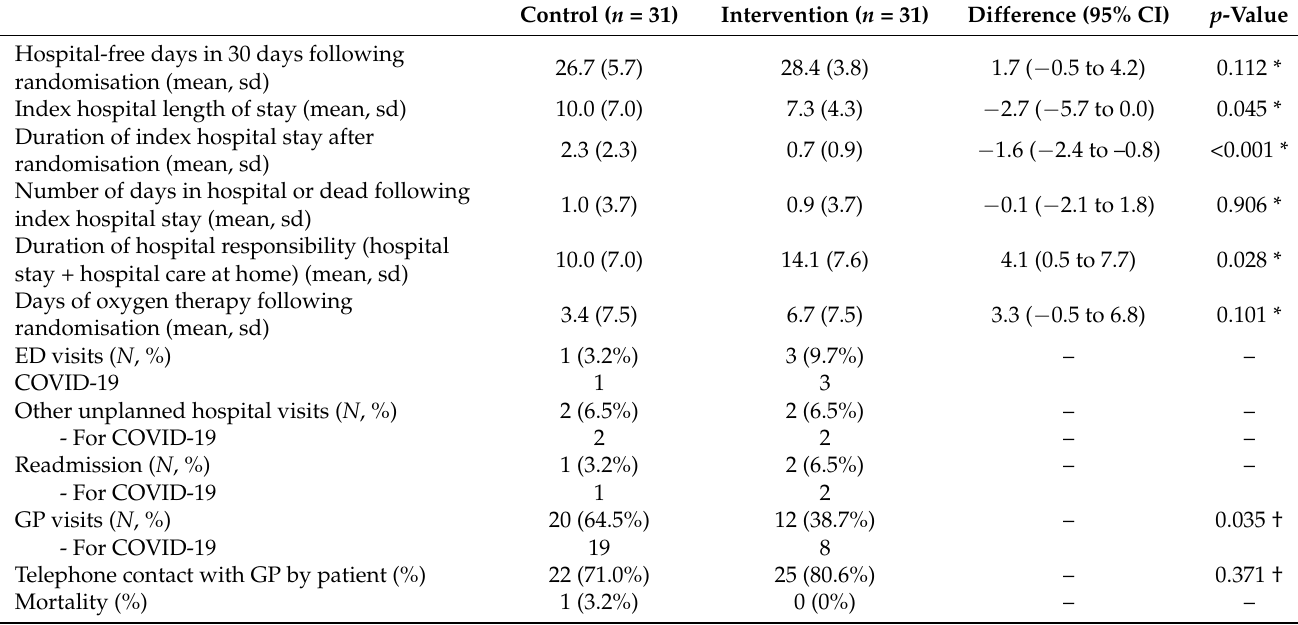
Table 2. Comparison of main